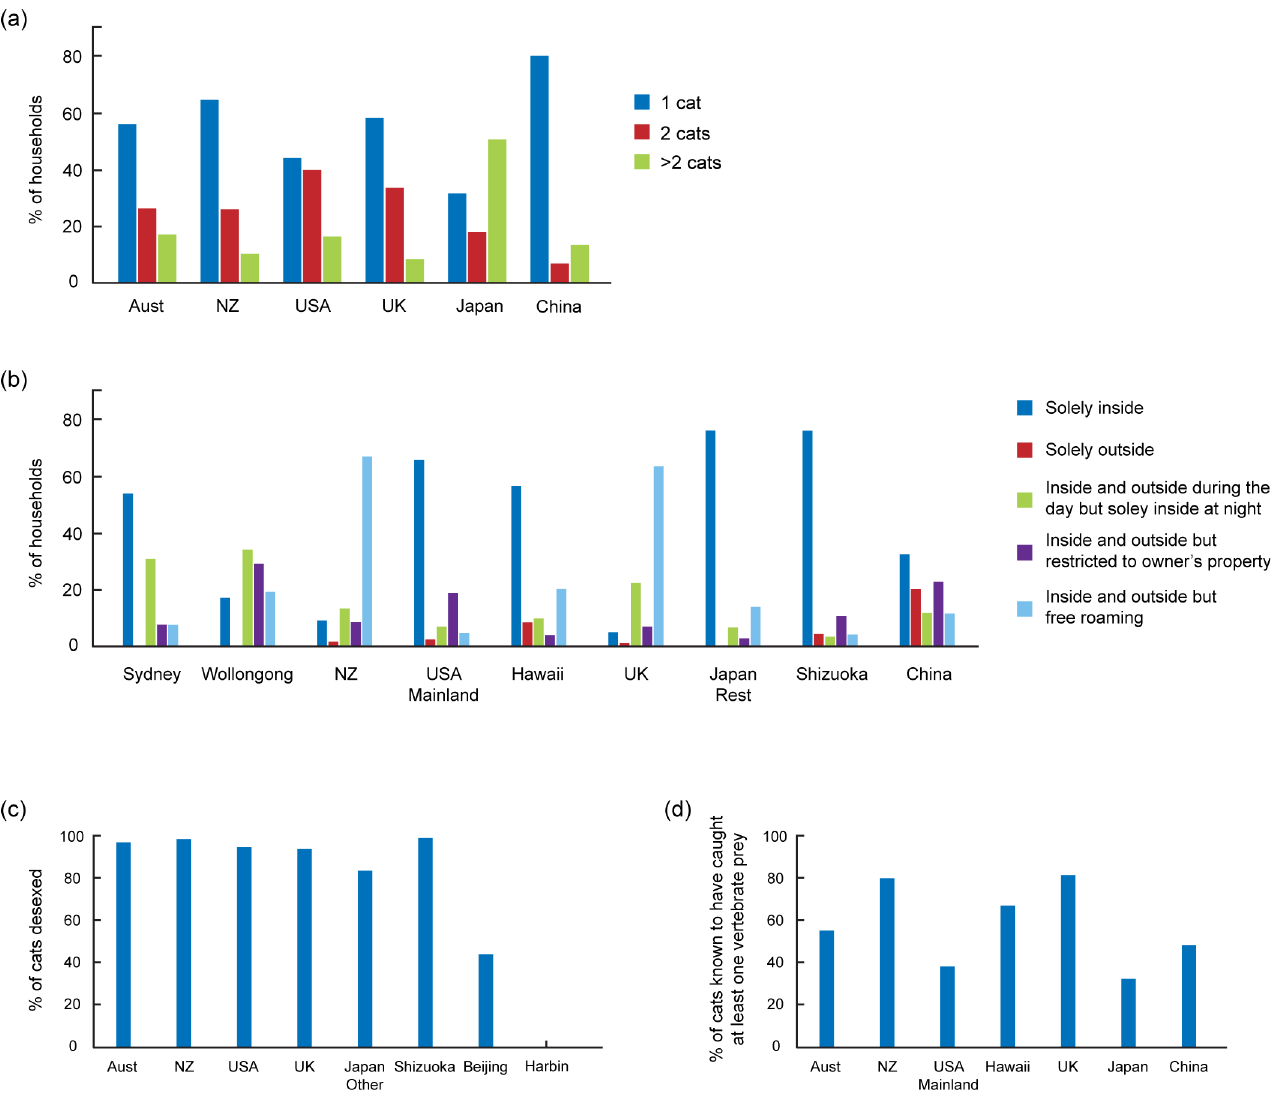
Fig 2. Cat husbandry practices in different countries. (a) Percentage of households that own one, two or more than two cats (b) Percentage of cats kept in different conditions of confinement (c) Percentage of desexed cats. (d) Percentage of cats that have ever caught vertebrate